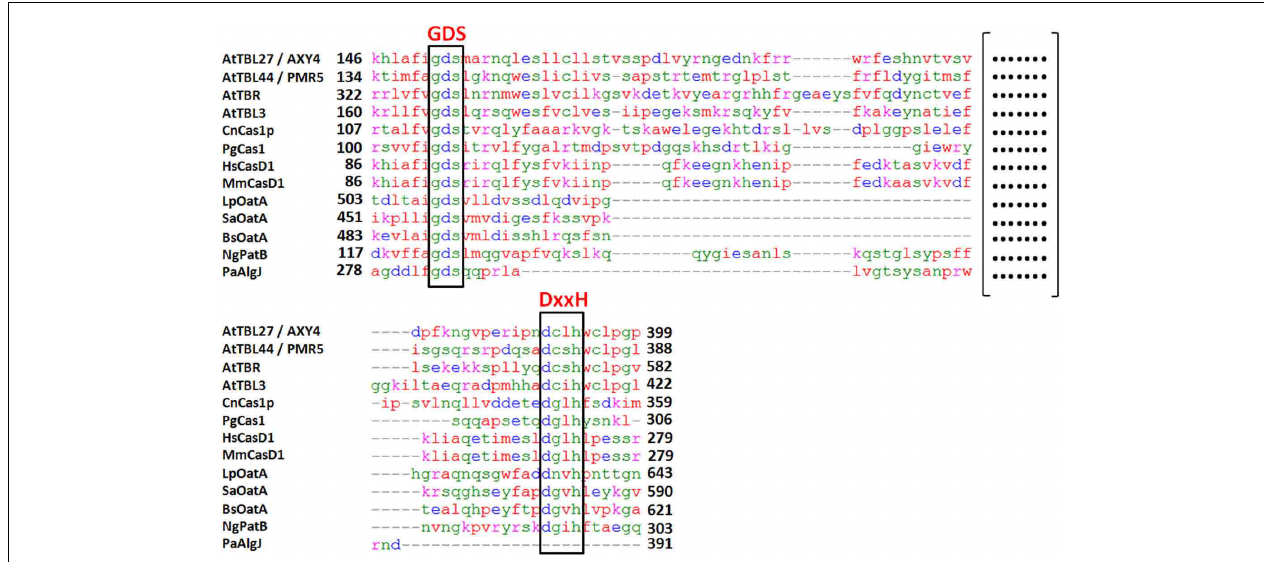
FIGURE 2 | Protein sequence alignment of domains containing the GDS and DxxH motives of proteins displayed in Figure 1. Alignment was performed using Kalign 2.0 (Lassmann and Sonnhammer, 2005). (Format: ClustalW, Gap open penalty: 30, Gap extension penalty: 0.2,Terminal Gap penalties: 0.45, Bonus score: 0). Proteins were trimmed to the amino acid residues given in bold numbers for the alignment. At, Arabidopsis thaliana ; Cn, Cryptococcus neoformans ; Pg, Puccinia graminis ; Hs, Homo sapiens